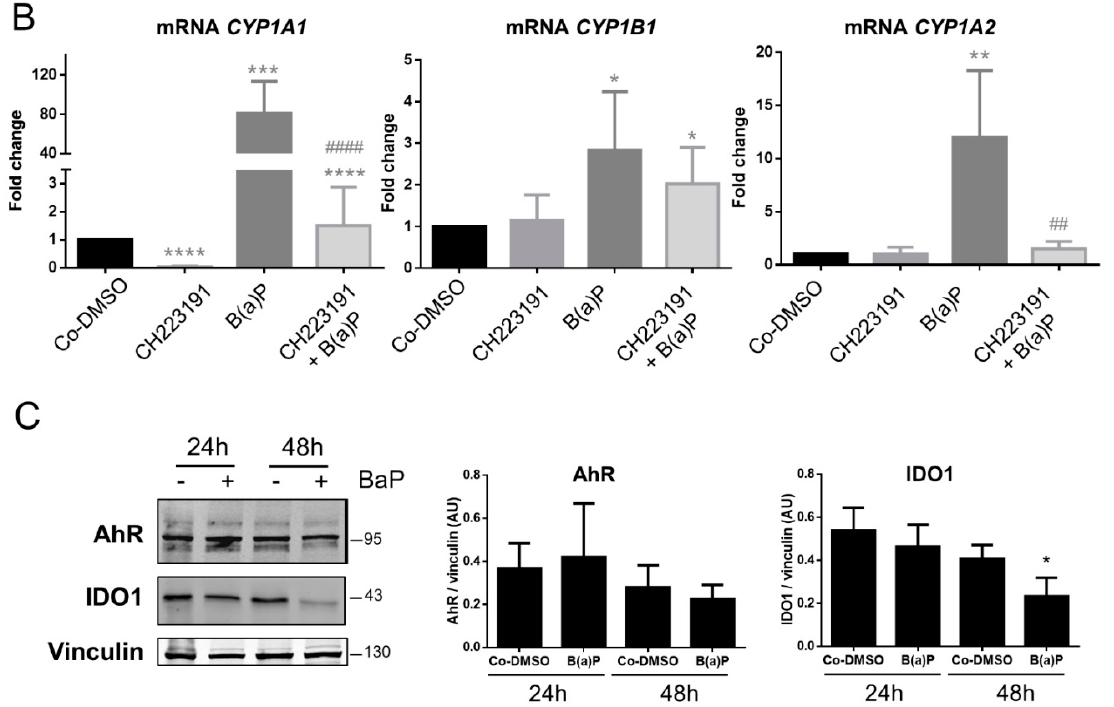
Figure 7. Impact of benzo-(a)-pyrene on AhR transcriptional activity. ( A ) Total RNA extracted from control BeWo cells (Co-DMSO) or incubated with 1 µ M of B(a)P for 24 h, were analyzed by RT-qPCR using primers for AhR , ARNT , and AhRR . Results are normalized to three reference genes ( HPRT , RPL13 , and Ubiquitin C ) and normalized to CK7 (KRT7) and are presented as fold change. The means (long horizontal lines) and standard deviations (short horizontal lines) of three different experiments are shown. ( B ) BeWo cells (control (Co-DMSO) or cells incubated with 1 µ M B(a)P for 24 h, in the presence or absence of 3 µ M CH223191, a specific AhR inhibitor (1 h before B(a)P)), were subjected to RT-qPCR after total RNA extraction. Levels of CYP1A1 , CYP1B1 , and CYP1A2 are presented as fold change, after normalization as above. * compared to Co-DMSO, # compared to B(a)P; * p < 0.05; ** or ## p < 0.01; *** p < 0.001; **** or #### p < 0.0001 ( n = 5). ( C ) Total protein extracts from chorionic villi (explants) of control term placenta (Co-DMSO) or incubated with 1 µ M B(a)P for 24 and 48 h, respectively, were subjected to Western blotting. Immunoblotting was carried out with anti-AhR, anti-IDO1, and anti-Vinculin (as loading control). The bar graph represents the total amount of AhR protein (two bands) or IDO1 relative to Vinculin level determined by quantification of immunoblots using the Odyssey System Imager. The means (long horizontal lines) and standard deviations (short horizontal lines) of three different placentae at term are shown. * compared to DMSO, p <